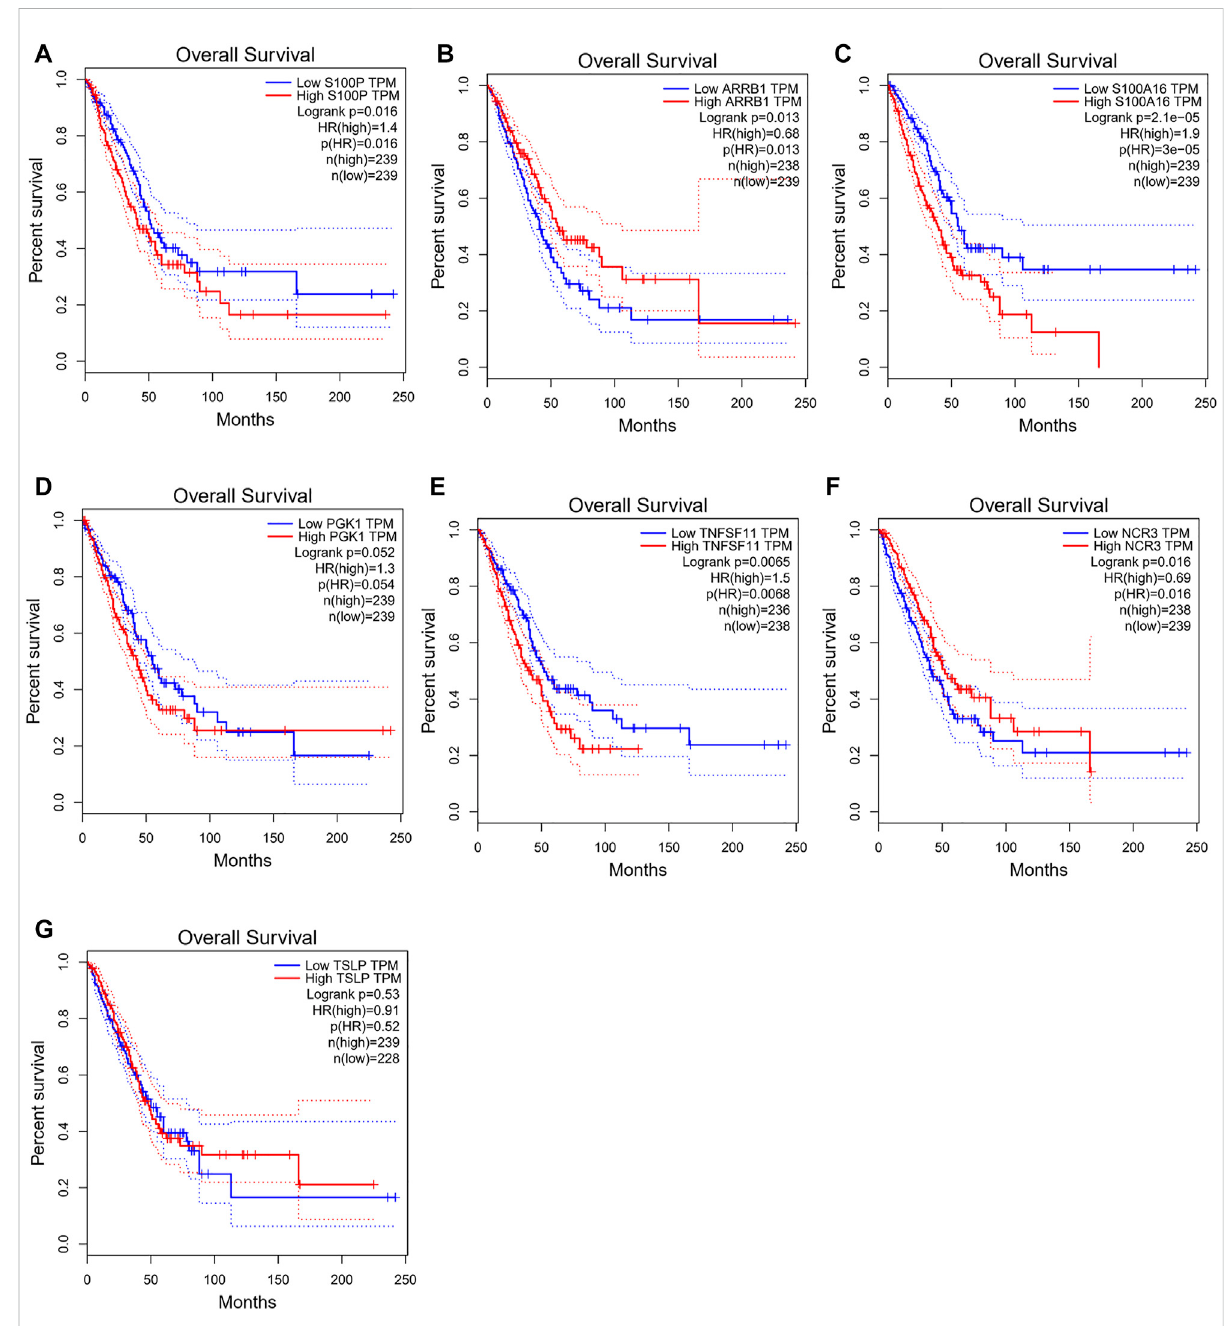
FIGURE 4 In fl uences of the seven genes on prognoses of LUAD patients. (A – G) Survival curves of patients with high and low expression of S100P (A) , ARRB1 (B) , S100A16 (C) , PGK1 (D) , TNFSF11 (E) , NCR3 (F) and TSLP (G)